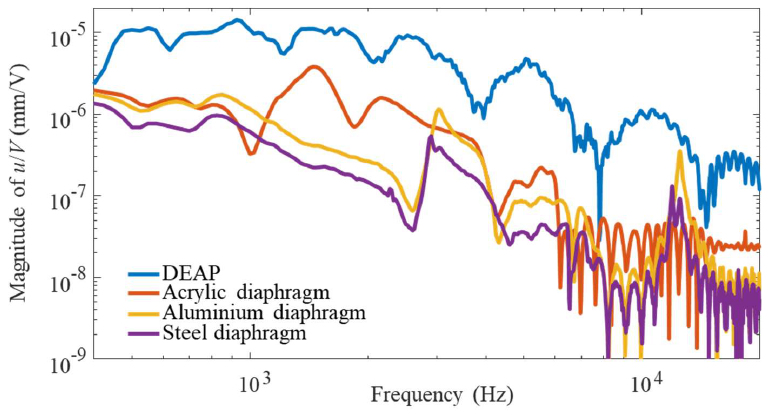
Figure 4. DEAP loudspeaker diaphragm displacement transfer function 𝑢/𝑉 obtained from velocity measurements by the Polytec ® PDV-100 laser vibrometer. The laser beam was directed at the centre of the top moving surface.